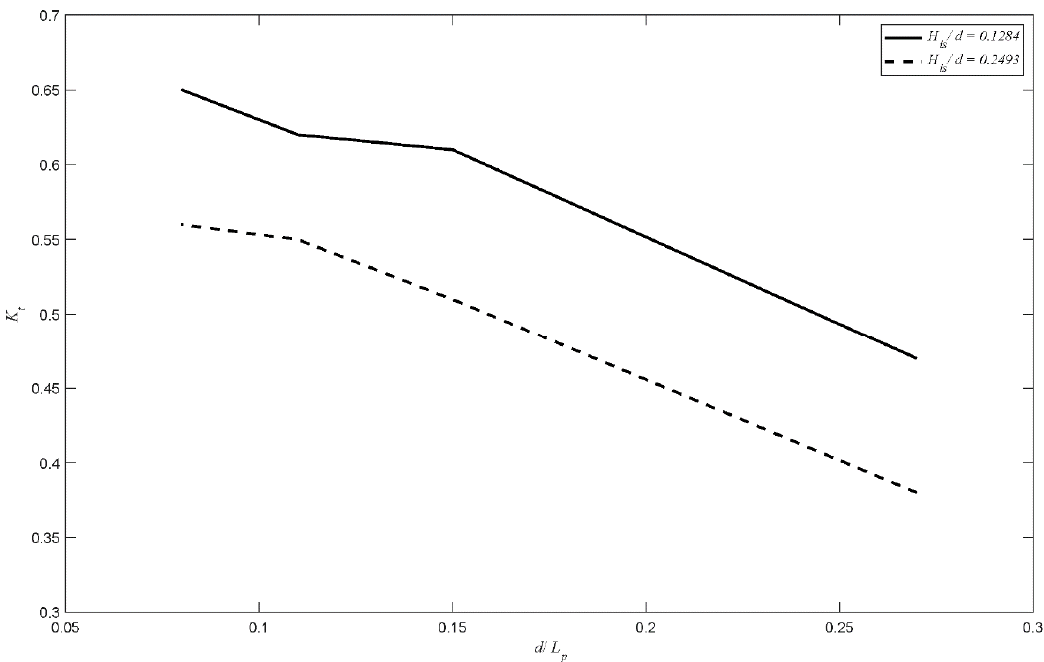
Figure 10. Effect of H is / d on the variation K t with d / L p , N = 2, P = 20%, and θ = 90 o .